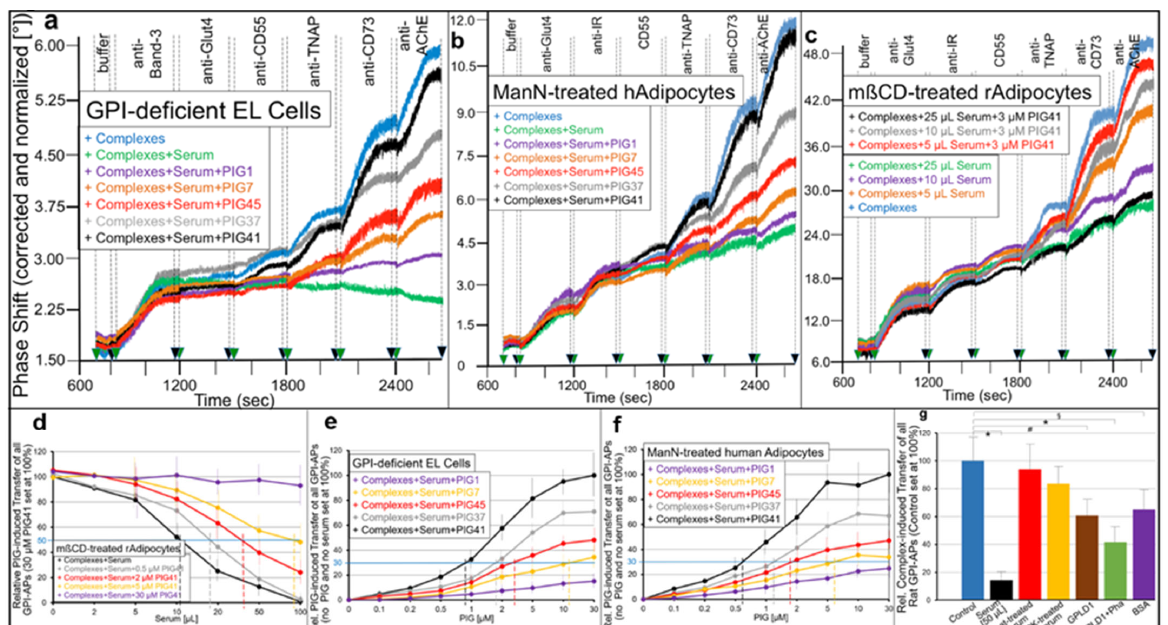
Figure 6. Effect of serum and PIGs on the transfer of full ‐ length GPI ‐ APs from micelle ‐ like GPI ‐ AP complexes to acceptor cells. ( a ) GPI ‐ deficient EL cells, ( b ) ManN ‐ treated human adipocytes of lipid ‐ loading stage II or ( c ) mßCD ‐ treated rat adipocytes were incubated (10 min, 37 °C) with micelle ‐ like rat adipocyte GPI ‐ AP complexes (5 arb. units) in the absence or presence of serum (30 μ L) and PIGs (30 μ M) ( a , b ) or as indicated ( c ). The expression of GPI ‐ APs and transmembrane proteins at PM prepared from the cells was analyzed by SAW sensing as described in the legend to Figure 1. ( d – f ) mßCD ‐ treated rat adipocytes ( d ), GPI ‐ deficient EL cells ( e ) and ManN ‐ treated human adipocytes ( f ) were incubated (60 min, 37 °C) with complexes (5 arb. units), serum (30 μ L) and increasing concentrations of PIGs ( e , f ) or in the absence (black curve) or presence of PIG41 (colored curves) and serum at the indicated concentrations and volumes, respectively ( d ). The mean values + SD of the phase shift Δ from four to six independent cell clones/preparations and incubations induced by all antibodies against rat GPI ‐ APs (summation signal between 1500 and 2700 s) were used for calculation of the relative PIG ‐ induced transfer of all rat GPI ‐ APs to acceptor cells with 30 μ M PIG41 in the presence of serum ( e , f ) or absence of both PIG41 and serum ( d ) set at 100%. The blue horizontal lines and the colored hatched vertical lines indicate ( e , f ) the concentration for 30% induction of transfer in the presence of serum for each PIG (EC 30 ) and ( d ) the serum volume for 50% inhibition of transfer in the absence or presence of PIG41 (IV 50 ). ( g ) mßCD ‐ treated rat adipocytes were incubated (60 min, 37 °C) with complexes (5 arb. units) in the absence (Control, blue bar) or presence of untreated (black bar), heat ‐ treated (red bar) or proteinase K ‐ treated (PK, yellow bar) serum (50 μ L) or GPLD1 (0.5 U) in the absence (brown bar) or presence of Pha (2 mM, green bar) or BSA (50 mg/mL, pink bar). The mean values + SD of the phase shift Δ from three to four independent complex/cell preparations induced by all antibodies against rat GPI ‐ APs (summation signal between 1500 and 2700 s) were used for calculation of the relative complex ‐ induced transfer of all rat GPI ‐ APs to acceptor cells with control set at 100% and significant differences vs. control indicated (* p < 0.01, # p < 0.02, § p < 0.05).